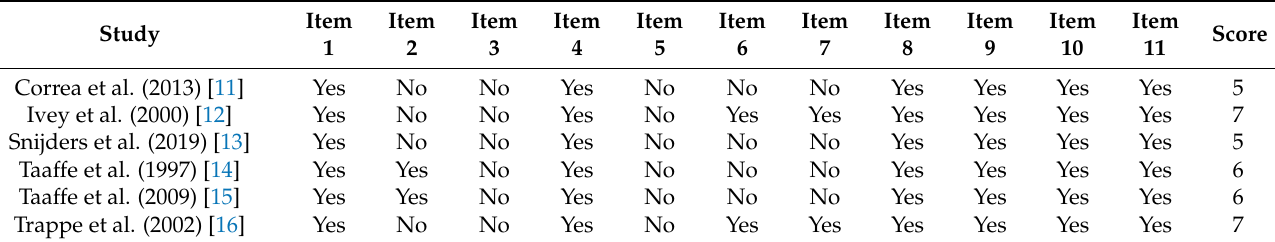
Table 2. Results from the PEDro